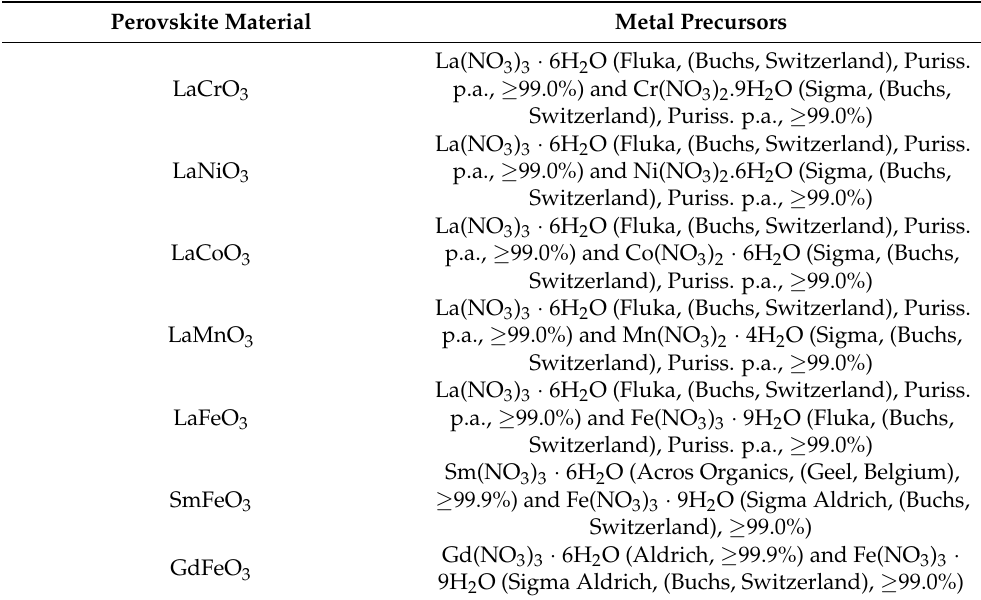
Table 2. Details of the raw materials used for sensitive materials